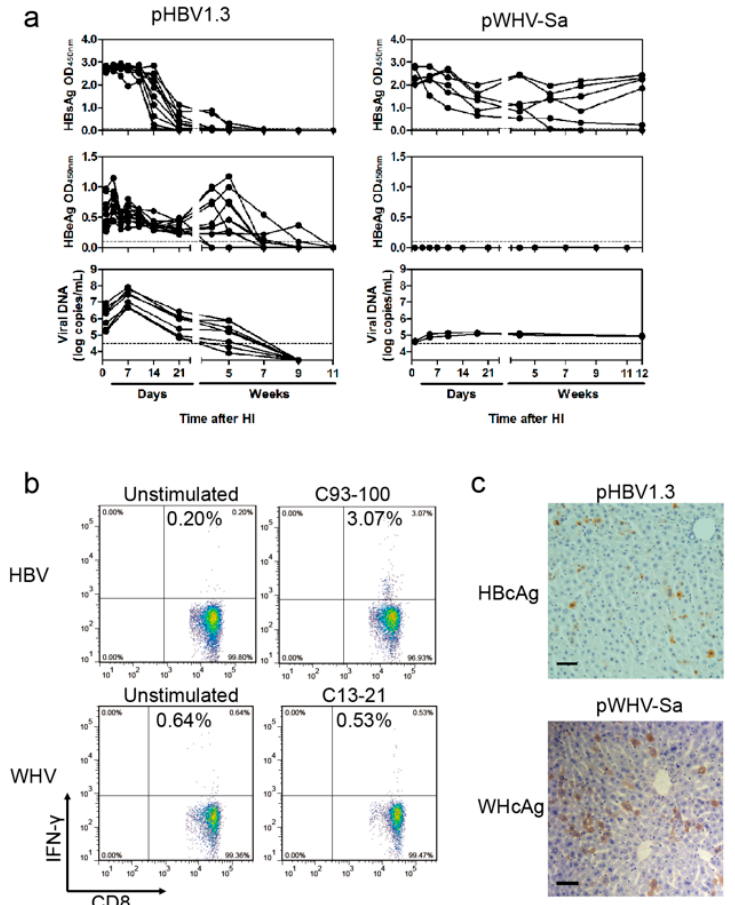
Figure 2. The kinetics of viral antigens and viral DNA (vDNA) in sera, the specific immune response, and hepatic antigen expression after HI with pHBV1.3 or pWHV-Sa in BALB/c mice. ( a ) In mouse sera, HBsAg and HBeAg were detected via ELISA, and the encapsidated vDNA was measured via real-time polymerase chain reaction (qPCR) at the indicated time points with pHBV1.3 or pWHV-Sa. The vector pBluescript II was used as negative control. The cutoff values for ELISA and qPCR were set as 0.1 and 3 × 104 copies/mL, respectively, which were indicated by the dotted line; ( b ) At four weeks after HI with pHBV1.3 (HBV) or pWHV-Sa (WHV) in C57BL/6 mice, the splenocytes were stimulated with HBV core antigen (HBcAg) peptide C93-100 or WHV core antigen (WHcAg) peptide C13-21, respectively. IFN- γ -producing CD8+ T cells were measured via flow cytometry; ( c ) At 10 days post infection (dpi), HBcAg or WHcAg expression in mouse livers were detected by immunohistochemical staining (IHC) after HI with pHBV1.3, pWHV-Sa or pBluescript II. Magnification: 200 ×.